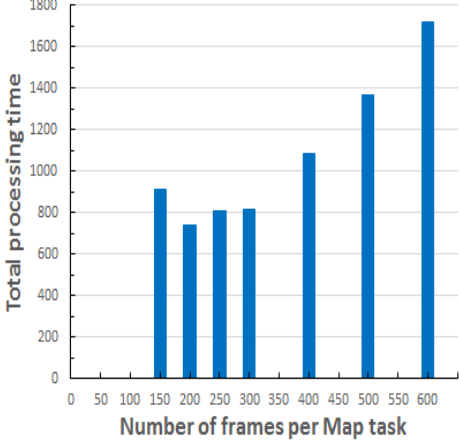
Figure 9. Configuration of the cluster system for Cloud computing in performance evaluation experiments.